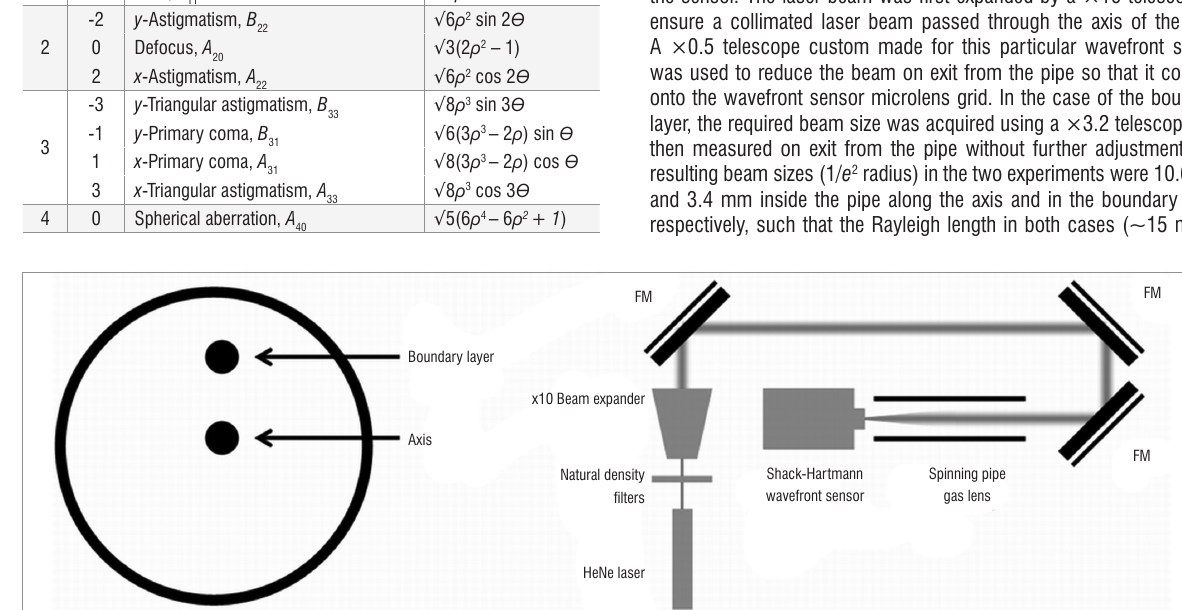
Spinning pipe gas lens